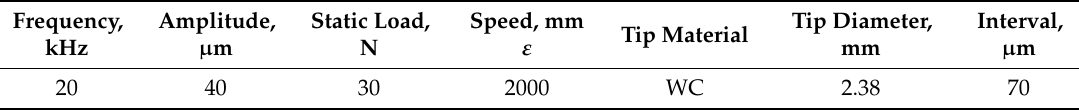
Table 2. Ultrasonic nanocrystalline surface modification (UNSM) parameters at room temperature (RT) and high temperature (HT) (1000 ◦